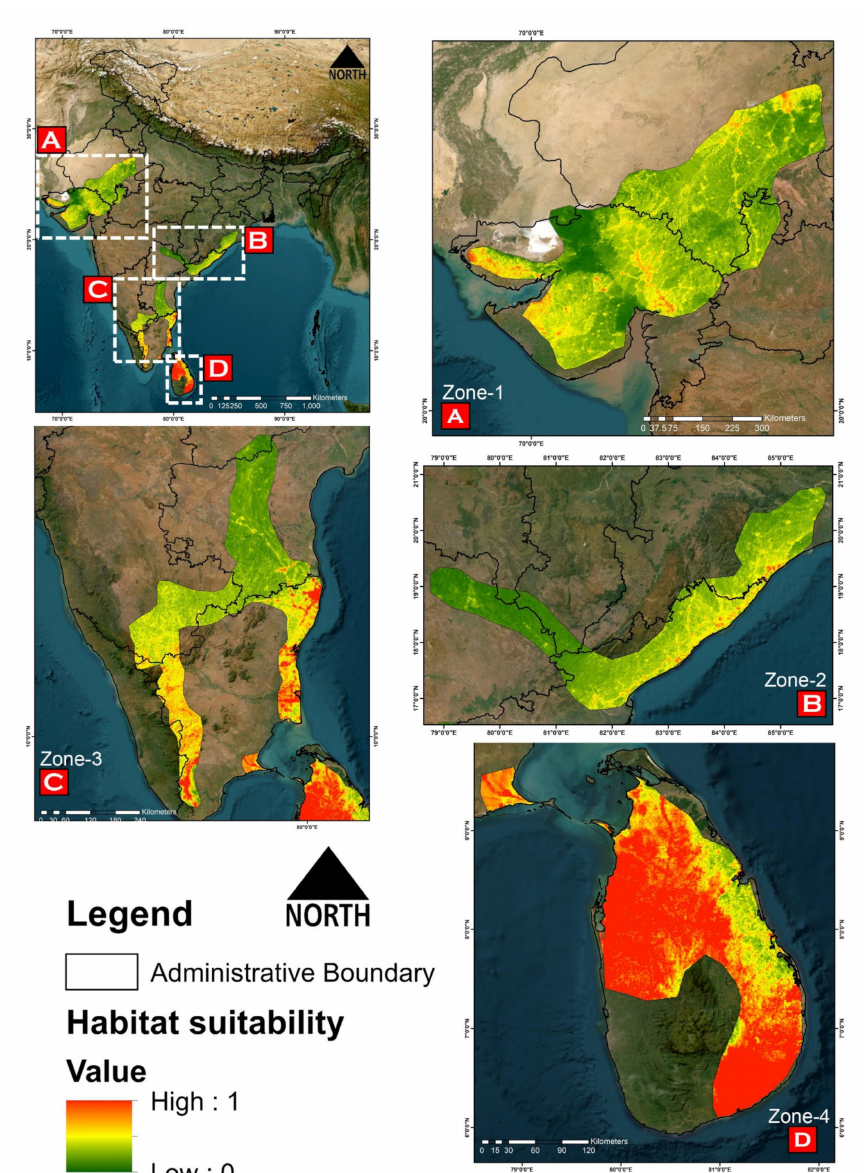
Figure 4. Representing the probability of suitable habitats of G. elegans within the distribution range. ( A ) Zone-1 comprising the western range within Gujarat and Rajasthan of India; ( B ) Zone-2 comprising the eastern range within Odisha and Telangana, and the north-eastern portion of Andhra Pradesh of India; ( C ) Zone-3 comprising the southern range within Tamil Nadu and Karnataka, and the central to southern parts of Andhra Pradesh; ( D ) Zone-4 comprising the north-western to south-eastern regions within Sri